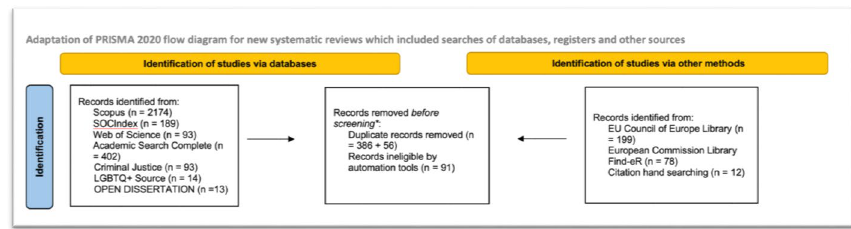
Fig. 1 Identification and selection of relevant